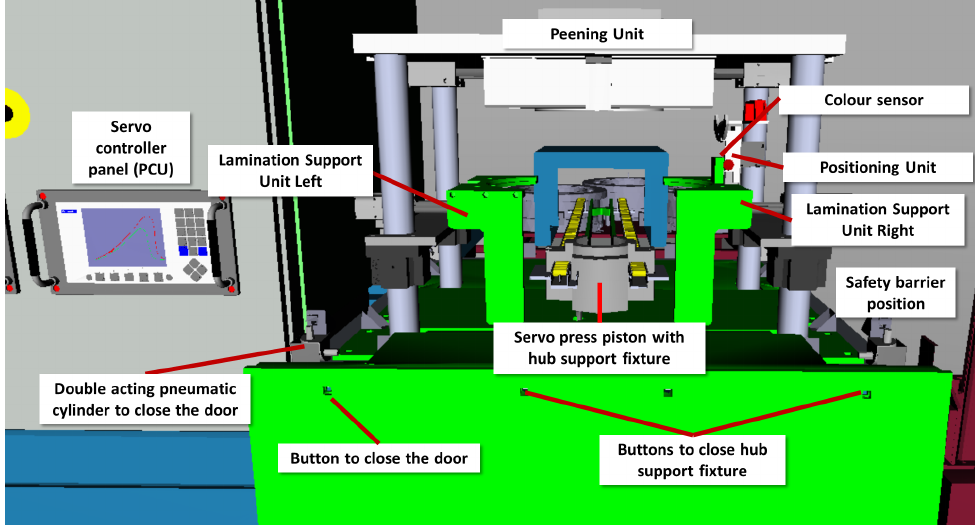
Figure 6. Virtual vertical assembly machine components.